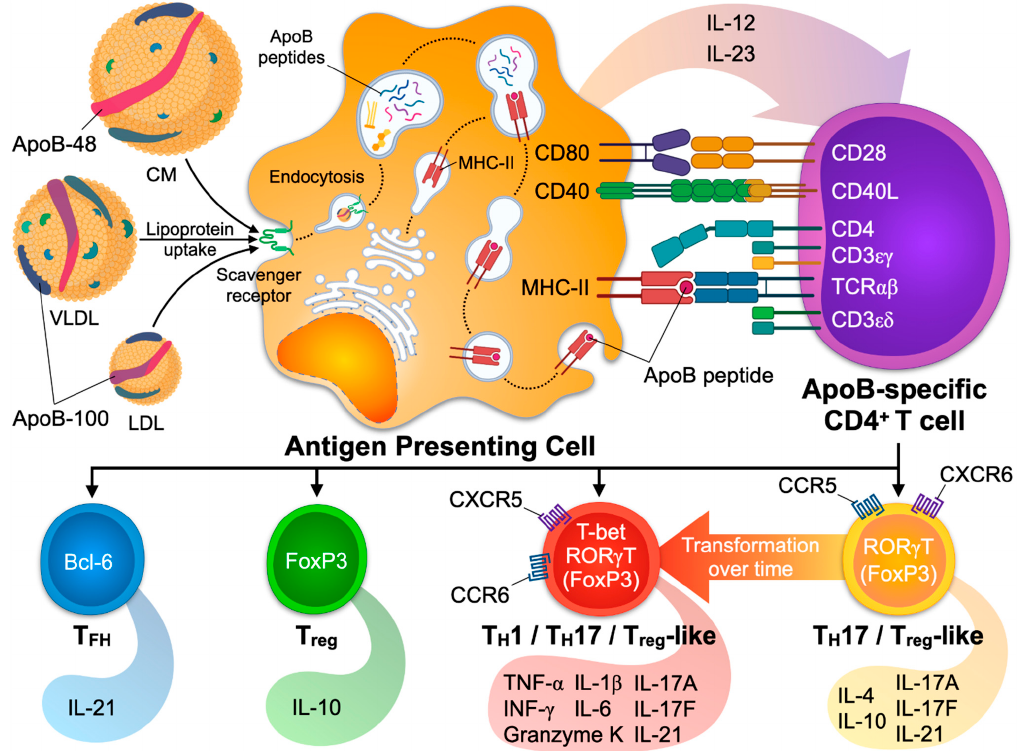
Figure 2. Activation and differentiation of ApoB-specific CD4 + T cells in mice. The ApoB-containing apolipoproteins LDL, VLDL, and chylomicrons (CM) are taken up by antigen-presenting cells (APCs) by endocytosis. After their intracellular processing, apolipoprotein-derived peptides are loaded on MHC-II molecules, before the entire MHC-II-peptide complex is transposed to the cell membrane. There, MHC-II-peptide complexes can be recognized and bound by a specific T cell receptor (TCR). In combination with sufficient co-stimulatory signaling events provided by the APC, a naïve CD4 + T cell is activated and may differentiate into distinct, partially overlapping T H -types of immunity: Most ApoB-specific CD4 + T cells (ApoB + ) express transcriptomes and markers of T H 17 and T-regulatory cells (T reg ). They express CCR5 and CXCR6, two known chemokine receptors (CCRs) required for aortic homing. Over time, ApoB + cells acquire additional pro-inflammatory transcriptional programs and express the T H 1 transcription factor T-bet, as well as the CCRs CXCR5 and CCR6. The initially detectable protective T reg signature is lost in this process. After vaccination, IL-10 secreting FoxP3 + ApoB + cells have been described at the site of vaccination. In transgenic mice, only expressing a TCR that recognizes a specific ApoB-peptide, a part of ApoB + cells differentiates into T FH that promote plasma cells generation and the production of LDL-lowering anti-LDL antibodies.